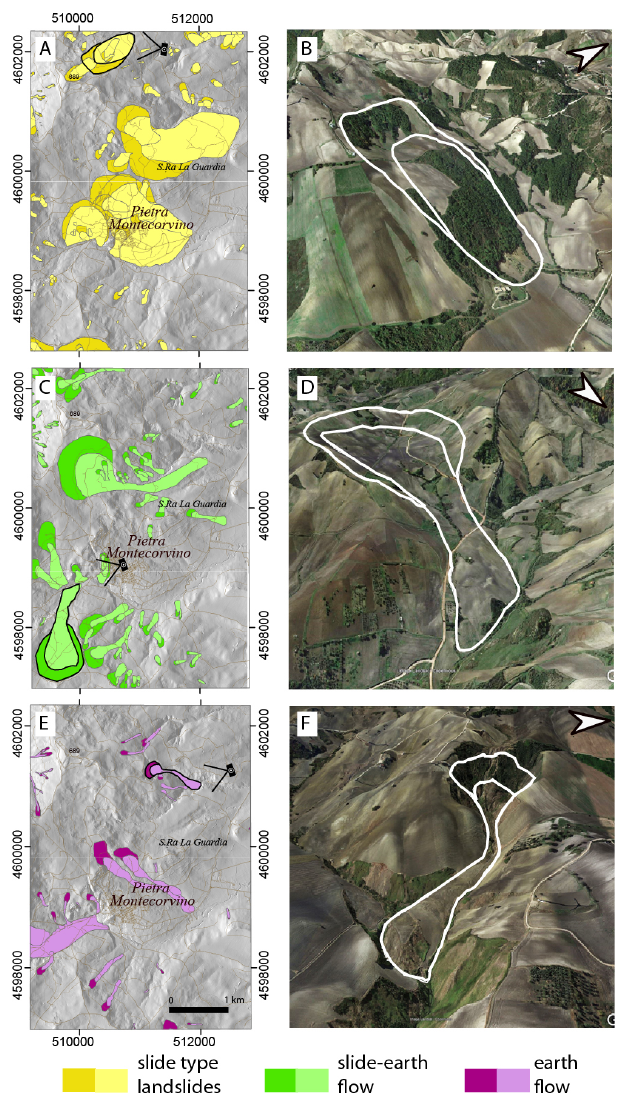
Figure 6. Examples on the map (a, c, e) and on © GoogleEarth™. Images (b, d, f) of slide-type failures (a, b) , slide-earthflow land- slides (c, d) , and earthflows (e, f) . For each row, black-outlined polygons and camera symbols in the left image identify the land- slide shown in the corresponding image on the right and the point of view,